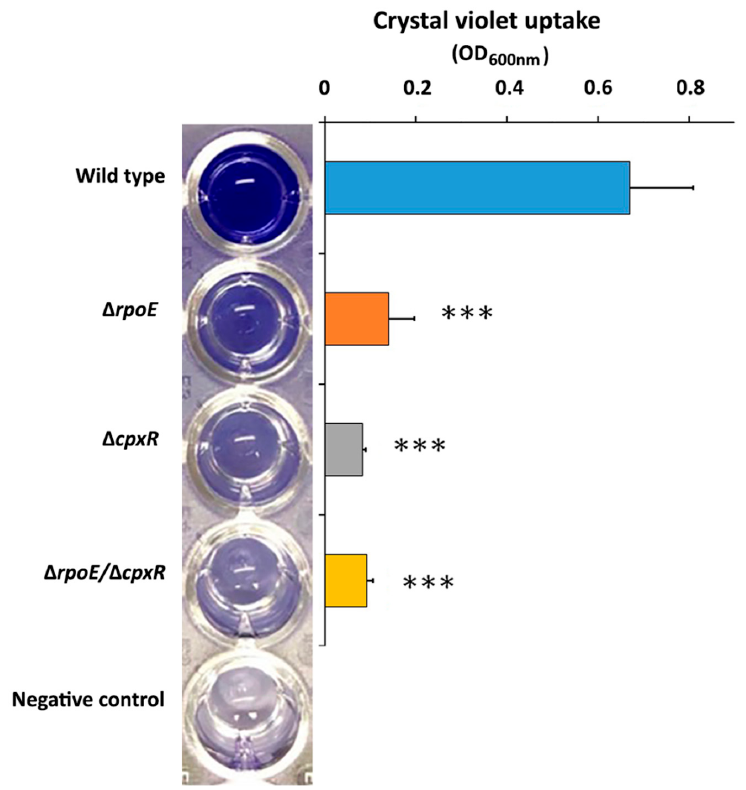
Figure 4. E ff ect of deletion of the rpoE, cpxR and rpoE / cpxR genes on the biofilm of S . Figure 4. Effect of deletion of the rpoE, cpxR and rpoE/cpxR genes on the biofilm of S . Enteritidis